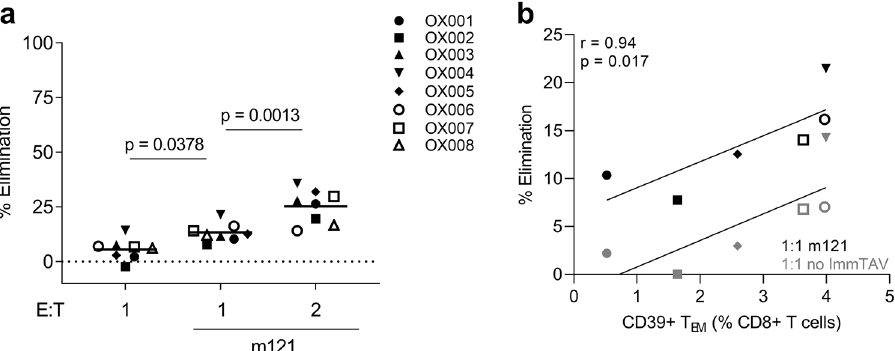
Figure 6. Elimination of resting infected CD4 + T cells by PLWH CD8 + T cells. Resting infected HD CD4 + T cells were co-cultured with CD8 + T cells from eight PLWH (E:T of 1:1 or 2:1) with and without m121 ImmTAV (0.5 nM) for 48 h. ( a ) Percent elimination was normalised to the percentage of Gag + cells in infected CD4 + T cell cultures alone. For technical reasons, the no ImmTAV condition at an E:T ratio of 2:1 was not included. ( b ) The percent elimination data from ( a ) for six of the PLWH with phenotyping data was plotted against CD39 expression in the T EM population with and without m121 ImmTAV. Mean values are indicated by horizontal bars. Groups were analysed by one-way ANOVA with Tukey’s multiple comparisons test or Spearman’s